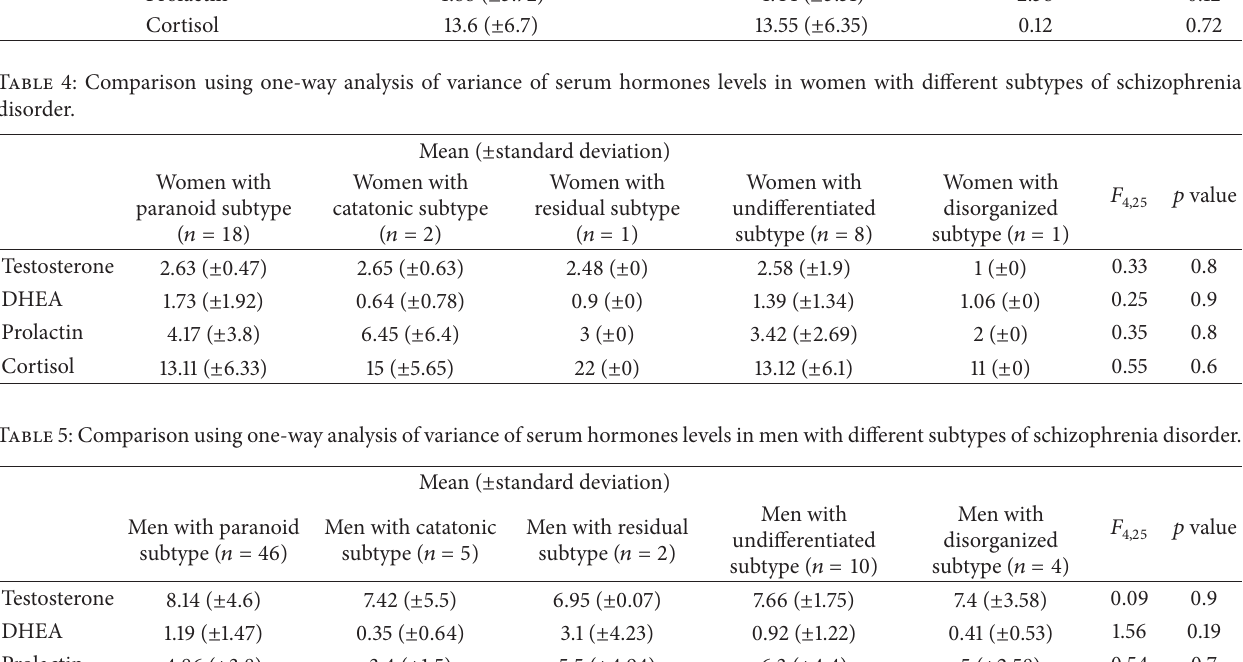
𝑝 valueMen with 𝐹 4,25